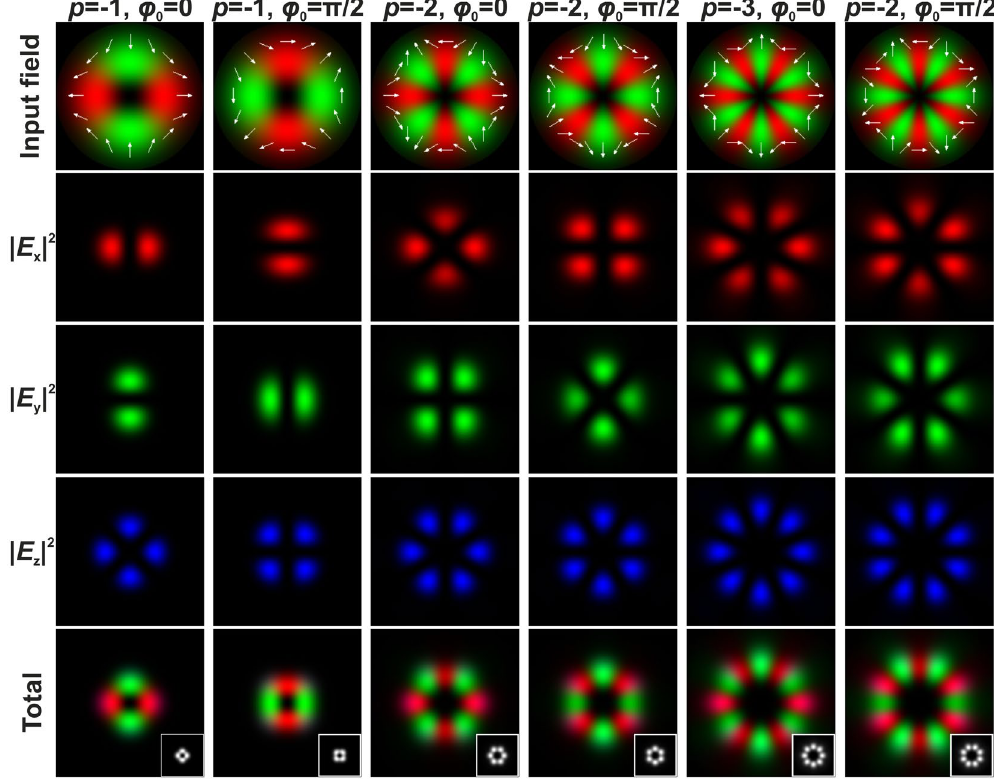
Figure 2. The distribution of the various components of the electric field in the focal plane of a focusing system (NA = 0.99) for an incident CVB with different negative polarisation order p and different inner polarisation rotation of the beam φ 0 . The insets in the total field distribution images show the generated grayscale intensity distributions. The white arrows show the schematic polarisation